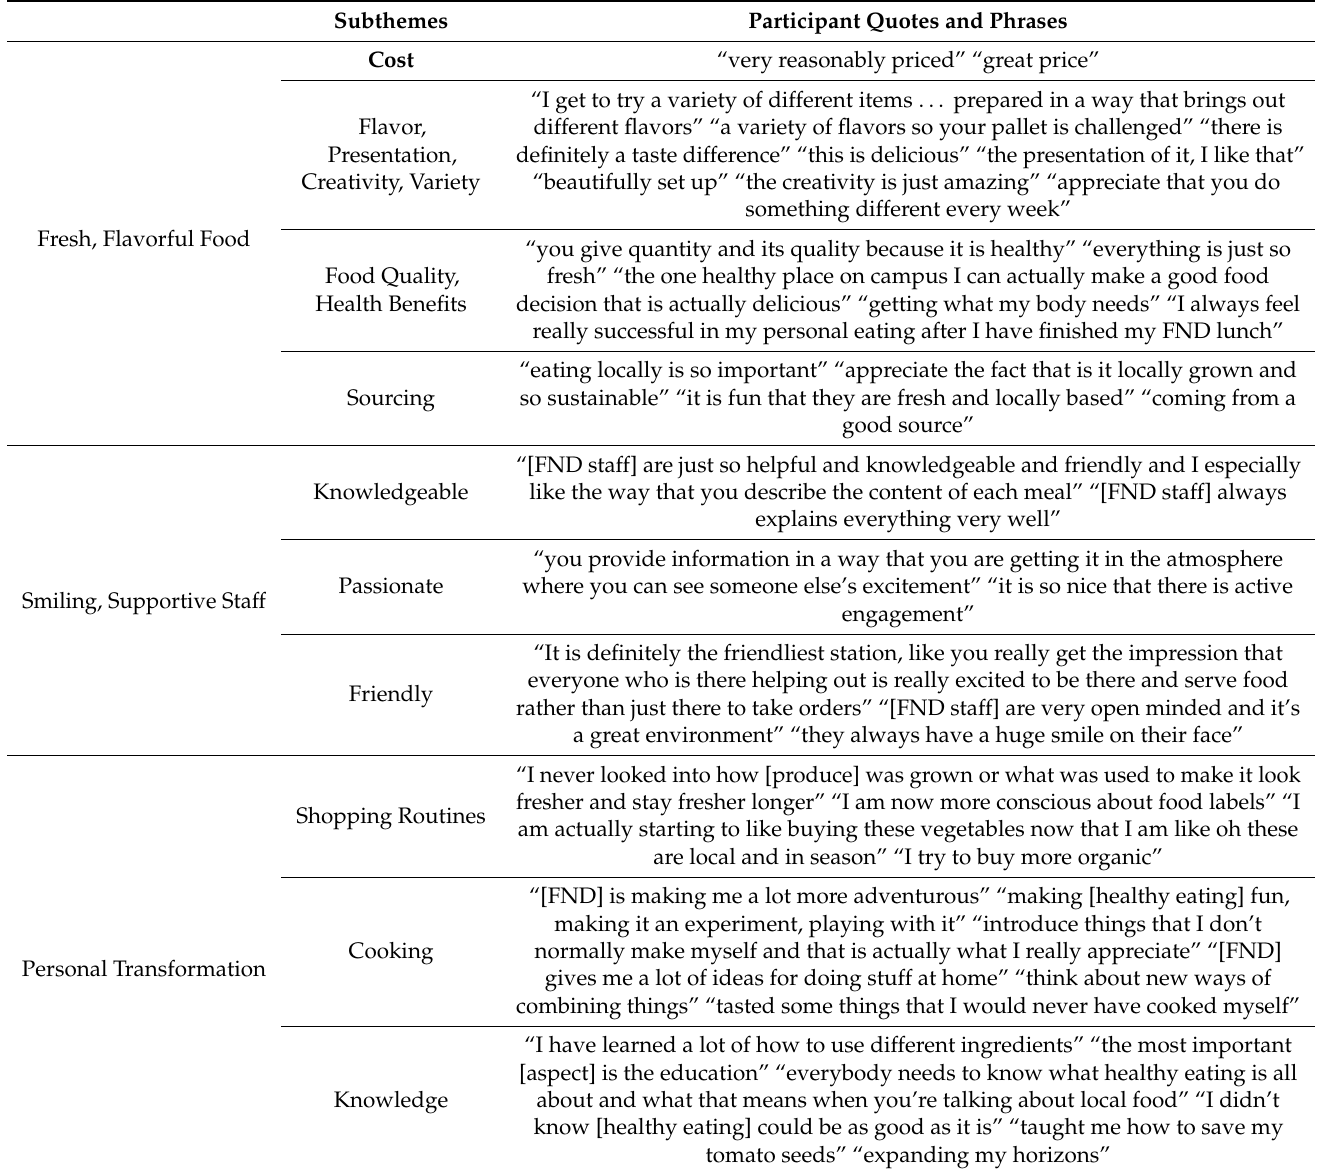
Table A2. Visual data display of themes, subthemes, and representative quotes of customers’ experiences.